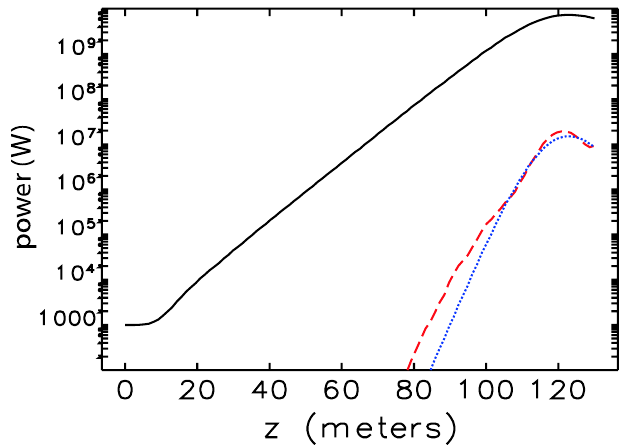
FIG. 12. (Color) Fundamental (black solid curve) and third- harmonic (red dashed curve) powers in GINGER seeded simula- tion for the LCLS parameters at the optimal frequency detuning. The analytical estimate according to Eq. (110) is shown as the blue dotted